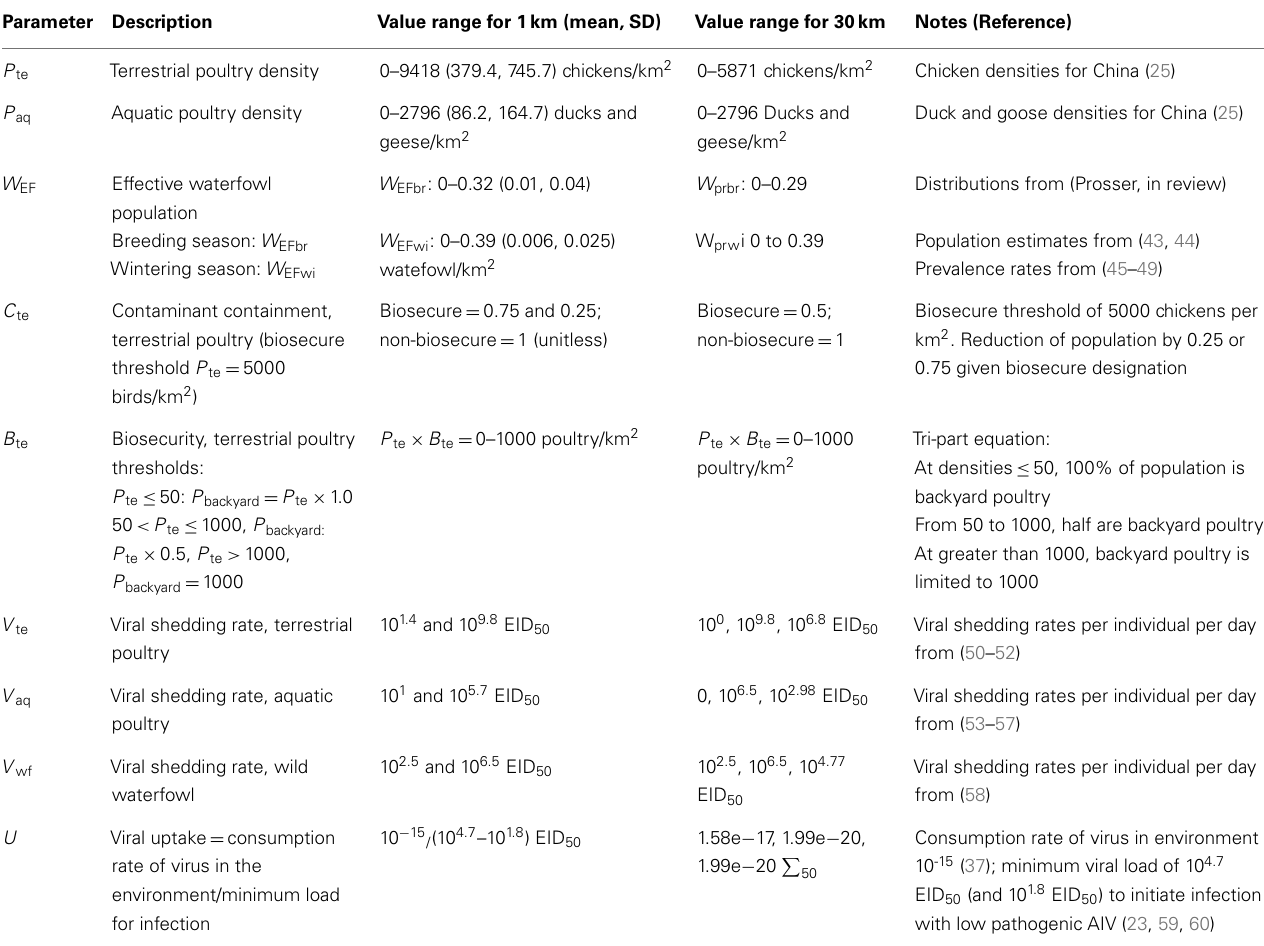
Table 1 | Parameters of 1km resolution transmission risk equations including the range of values, approach for sensitivity analyses, and reference for